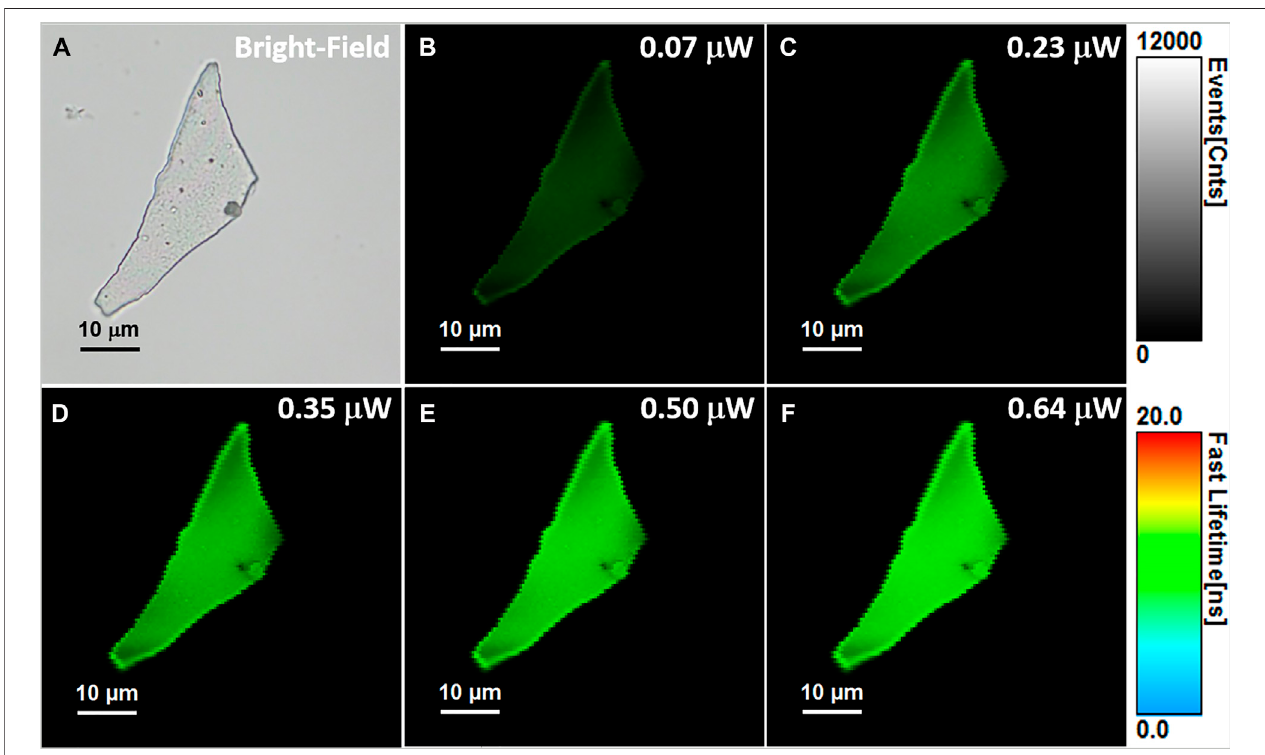
FIGURE 2 | (A) Optical image of the investigated BSA-AuNCs micro fl ake powder. (B – F) OPE FLIM images of BSA-AuNCs micro fl ake powder under 405 nm excitation using different laser power on the probe, ranging from 0.07 to 0.64 µW. All FLIM images are presented on the same intensity (0-12,000 counts) and lifetime (0 – 20 ns) scales. The images were recorded at a resolution of 150 × 150 px with an imaging speed of 64 s.